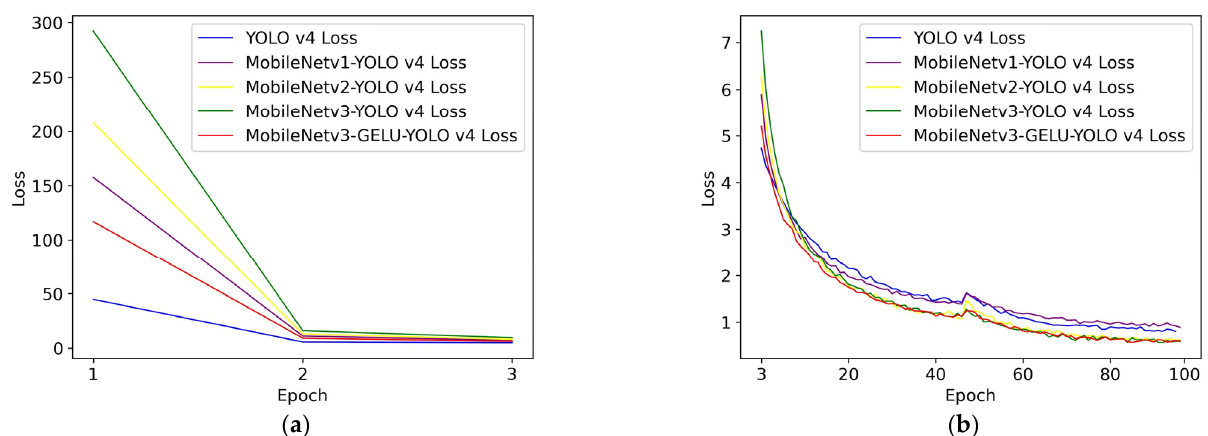
Figure 5. Training loss function plots ( a ) first three epochs; ( b ) after three epochs.